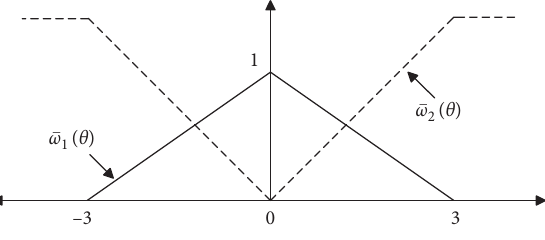
Figure 1: Tunnel diode circuit.